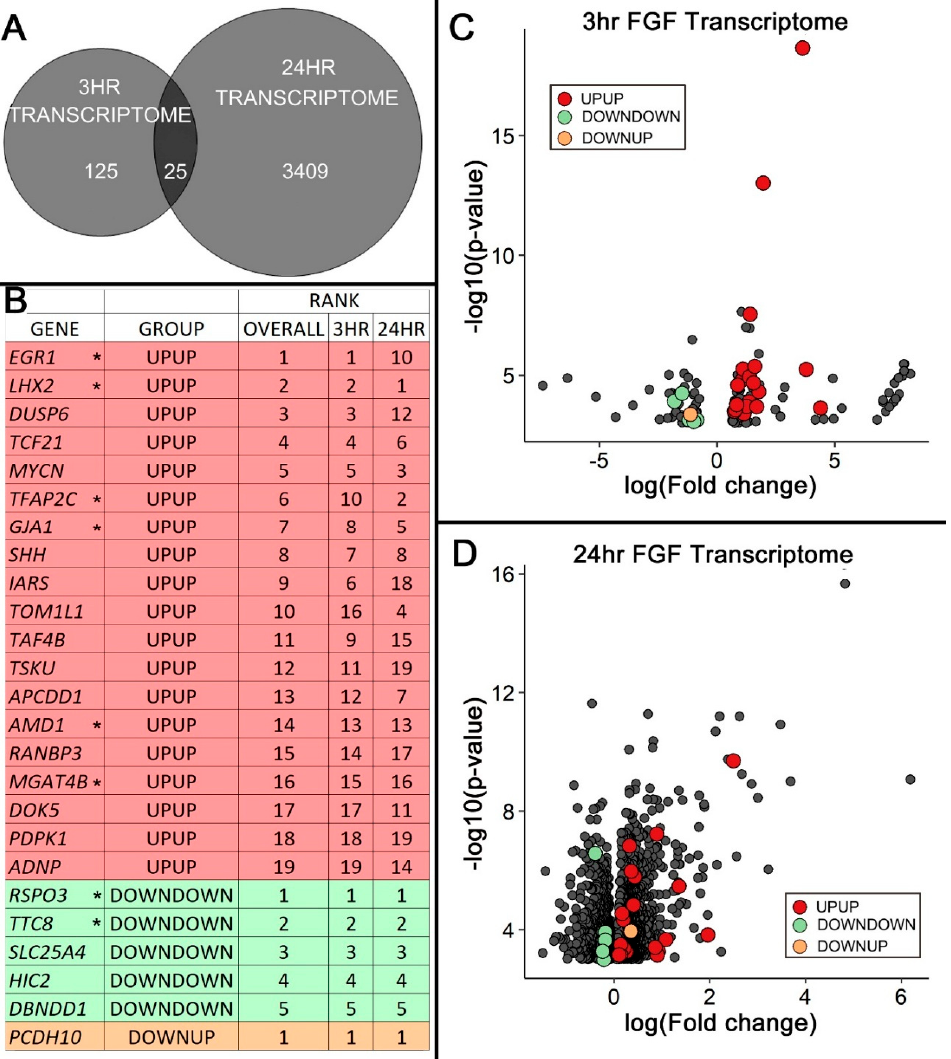
Figure 4. Common transcripts regulated by FGF2 during maintenance and induction of SHH expression are likely candidates for FGF-mediated SHH expression. ( A ) The number of FGF-regulated transcripts common to both 3 and 24 h datasets is shown in the overlapping region of the Venn diagram (n = 25). ( B ) Table showing the 25 common targets from the 3 and 24 h transcriptome that are likely candidates for FGF-mediated SHH expression. Targets are ranked based on differential expression (fold change) divided by significance ( p -value). Asterisks (*) denote genes associated to SHH expression/function. Genes upregulated at both 3 and 24 h are designated with Group ID “UPUP”: red (n = 19). Genes downregulated at both time points are designated “DOWNDOWN”: green (n = 5), while genes downregulated at 3 h and upregulated at 24 h are designated “DOWNUP”: orange (n = 1). ( C ) Distribution (by log10 p -value and log2 fold change) of the 150 genes differentially regulated after 3 h FGF treatment, with the 25 common targets highlighted in color ( p < 0.05). ( D ) Distribution (by log10 p -value and log2 fold change) of the 3434 genes differentially regulated by 24 h FGF treatment, with the 25 common targets highlighted in color ( p < 0.05).